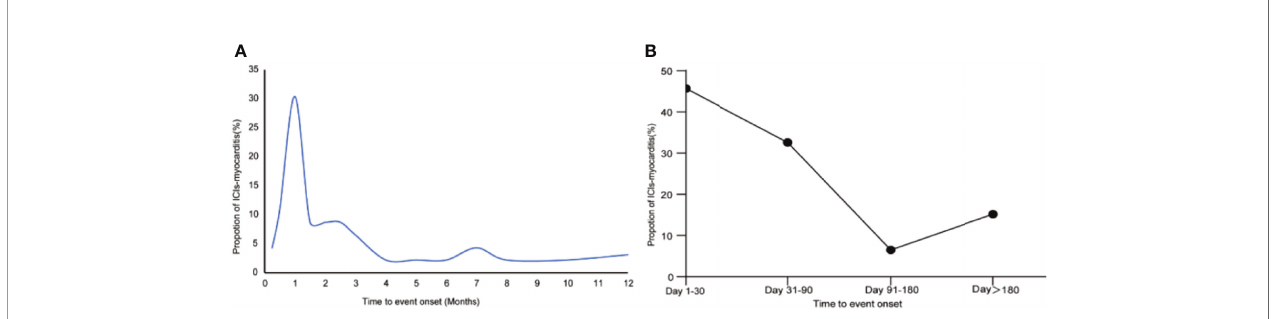
FIGURE 1 | Time to event onset of ICI myocarditis. (A) Incidence trend by month to event onset. (B) Incidence trend by time period (day 1-30, day 31-90, day 91- 180, day >